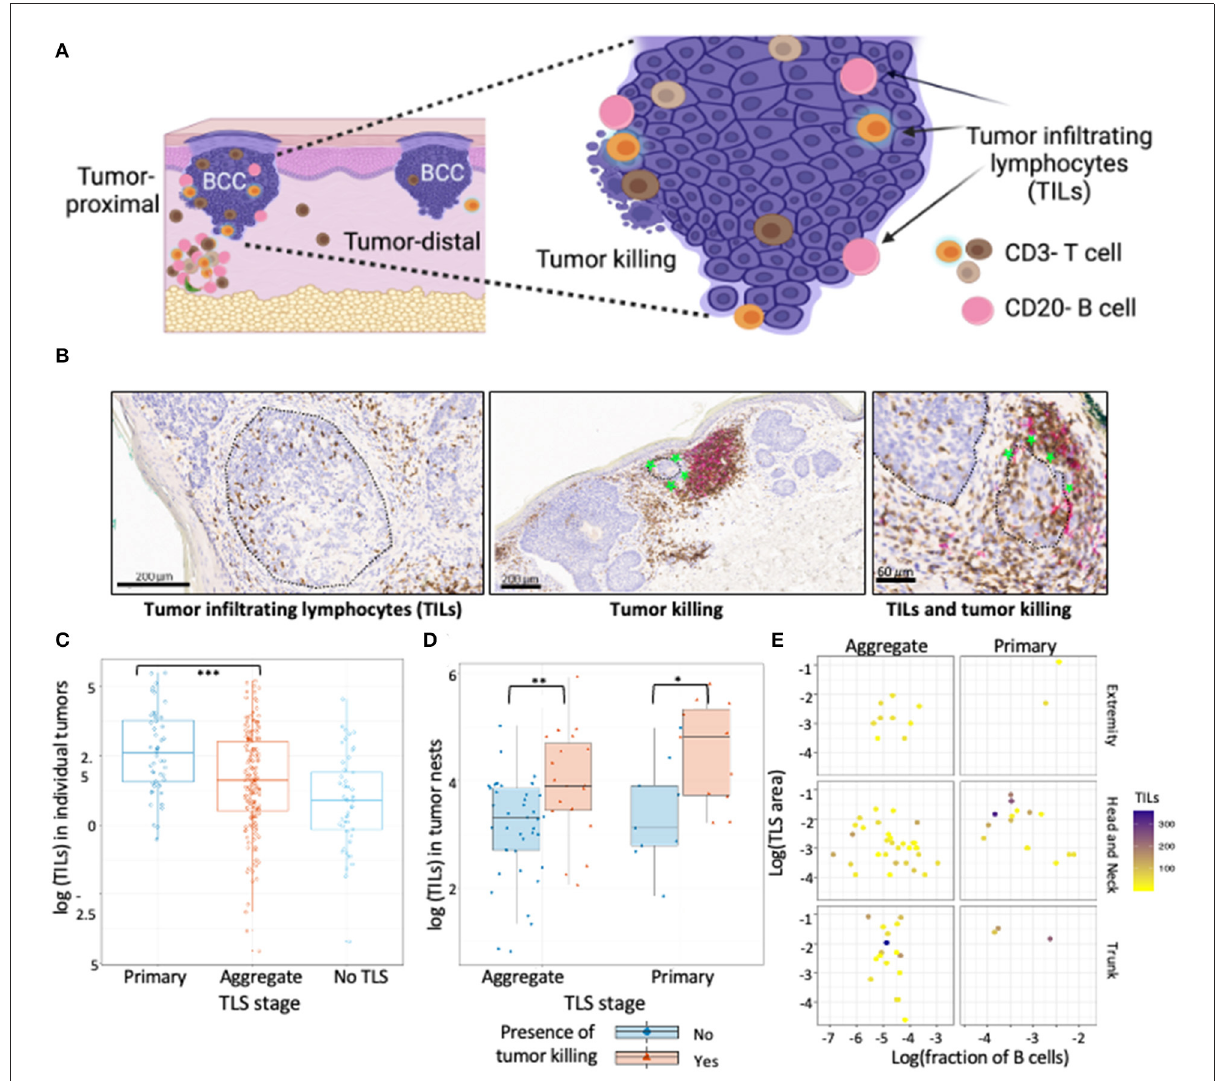
FIGURE2 TILs in BCC show association with TLS presence and maturation. (A) Schematic representation of tumor location with respect to TLS, TILs and tumor killing in BCC tumors. Proximal tumors were defined as adjacent to TLS, distal tumors were located farthest from the TLS. Infiltrating T and B cells inside annotated tumor boundaries were quantified and referred to as TILs. Tumor killing was defined as active tumor regression involving a combination of infiltrating immune cells along tumor periphery leading to disruption of the palisaded architecture and was graded as a binary variable for presence or absence. (B) Representative CD3/CD20 IHC images of TILs and tumor killing demonstrating CD3 + T cells (brown) and CD20 + B cells (pink) cells inside tumors (black encircled structures). Infiltrating CD3 + and CD20 + lymphocytes inside BCC tumors were referred to as TILs while infiltrating of immune cells along tumor edge that accompany a disrupted tumor border was referred to as tumor killing (green stars). (C) TILs distribution in tumors proximal to primary TLS, aggregate TLS and control cases (no TLS); data points represent individual tumors. Tumors proximal to primary TLS show significantly higher mean of TIL counts compared to tumors proximal to aggregate TLS ( p- value < 0.001, approximated with Wald tests of the fixed effect in a linear mixed-effects model of Box-Cox transformed count of TILs, see Table 3). (D) Abundance of TILs in tumor nests proximal to TLS denoted for presence of tumor killing. Presence of tumor killing is associated with higher TIL counts for tumor nests proximal to primary TLS ( p- value = 0.029) and similarly for tumor nests proximal to aggregate TLS ( p- value = 0.01). P- values derived from Wald test for fixed effects in linear mixed-effect models. (E) Observation of TILs distribution with combined effect of TLS properties, TLS stage and body site; data point represents tumor nests. No significant difference in median TILs